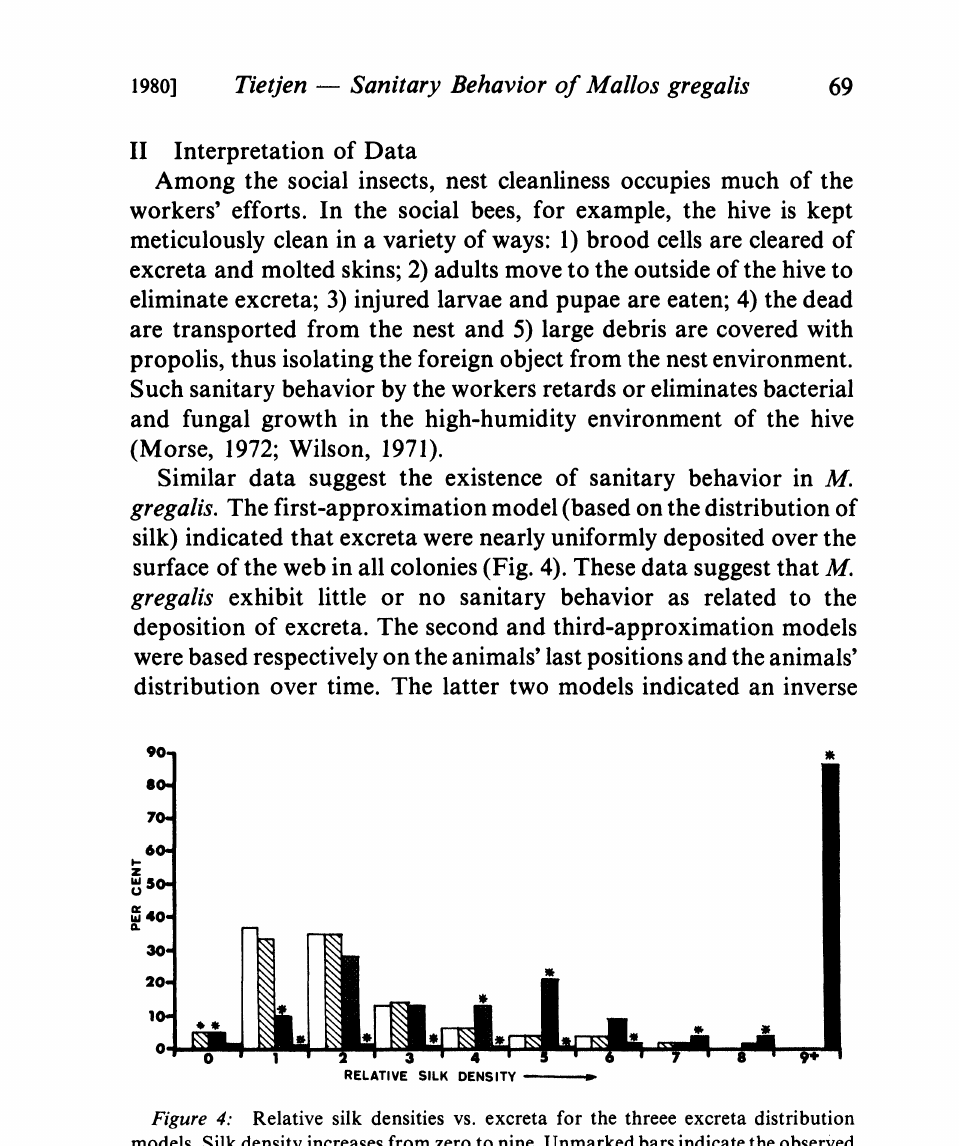
Figure 4: Relative silk densities vs. excreta for the threee excreta distribution models. Silk density increases from zero to nine. Unmarked bars indicate the observed distribution of feces for each relative silk density range. Cross-hatched bars represent the expected distribution based on the absolute quantity of silk within each density range (Model 1). Stippled bars are the expected distribution of excreta based on the animals’ last positions (Model 2). The dark bars represent the expected distribution of excreta based on continuous recording of the animals’ movements (Model 3). The asterisk-marked bars indicate a significant deviation from the observed excreta dis- tribution (Chi-square test,